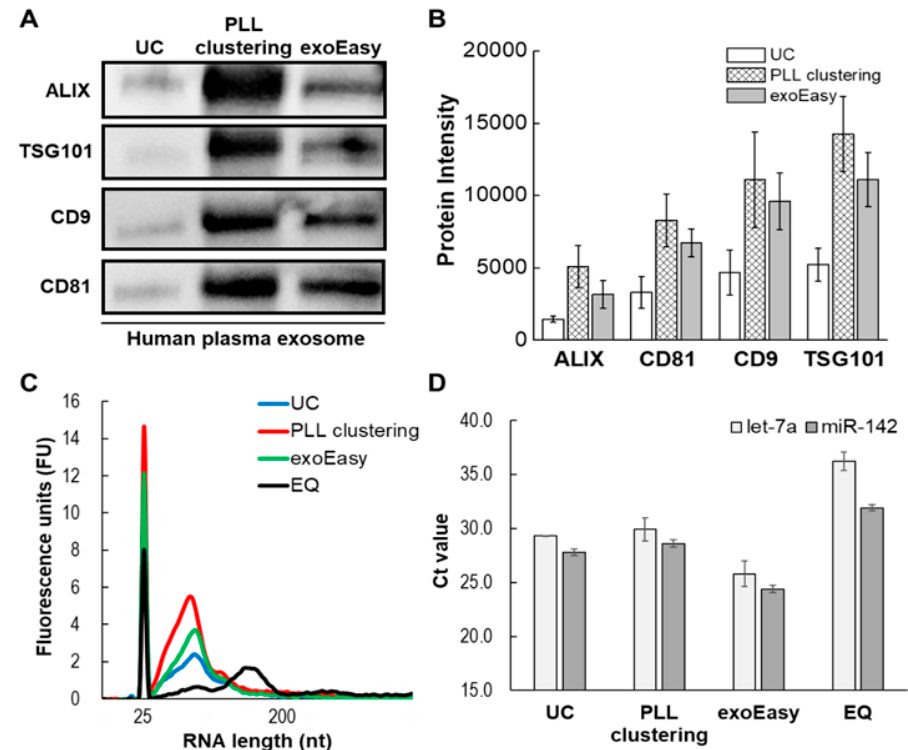
Figure 7. Comparison of EV isolation methods (UC, EQ, exoEasy, PLL clustering) via Western blot, bioanalyzer and RT-qPCR. ( A ) Band images of Western blot assay. ( B ) Protein level of four EV markers measured by band intensity. ( C ) Total EV RNA extracts analyzed on Agilent Eukaryote Total RNA Pico chips using a bioanalyzer. ( D ) EV miRNAs (hsa-let-7a-5p, hsa-miR-142-3p) were confirmed by RT-qPCR.